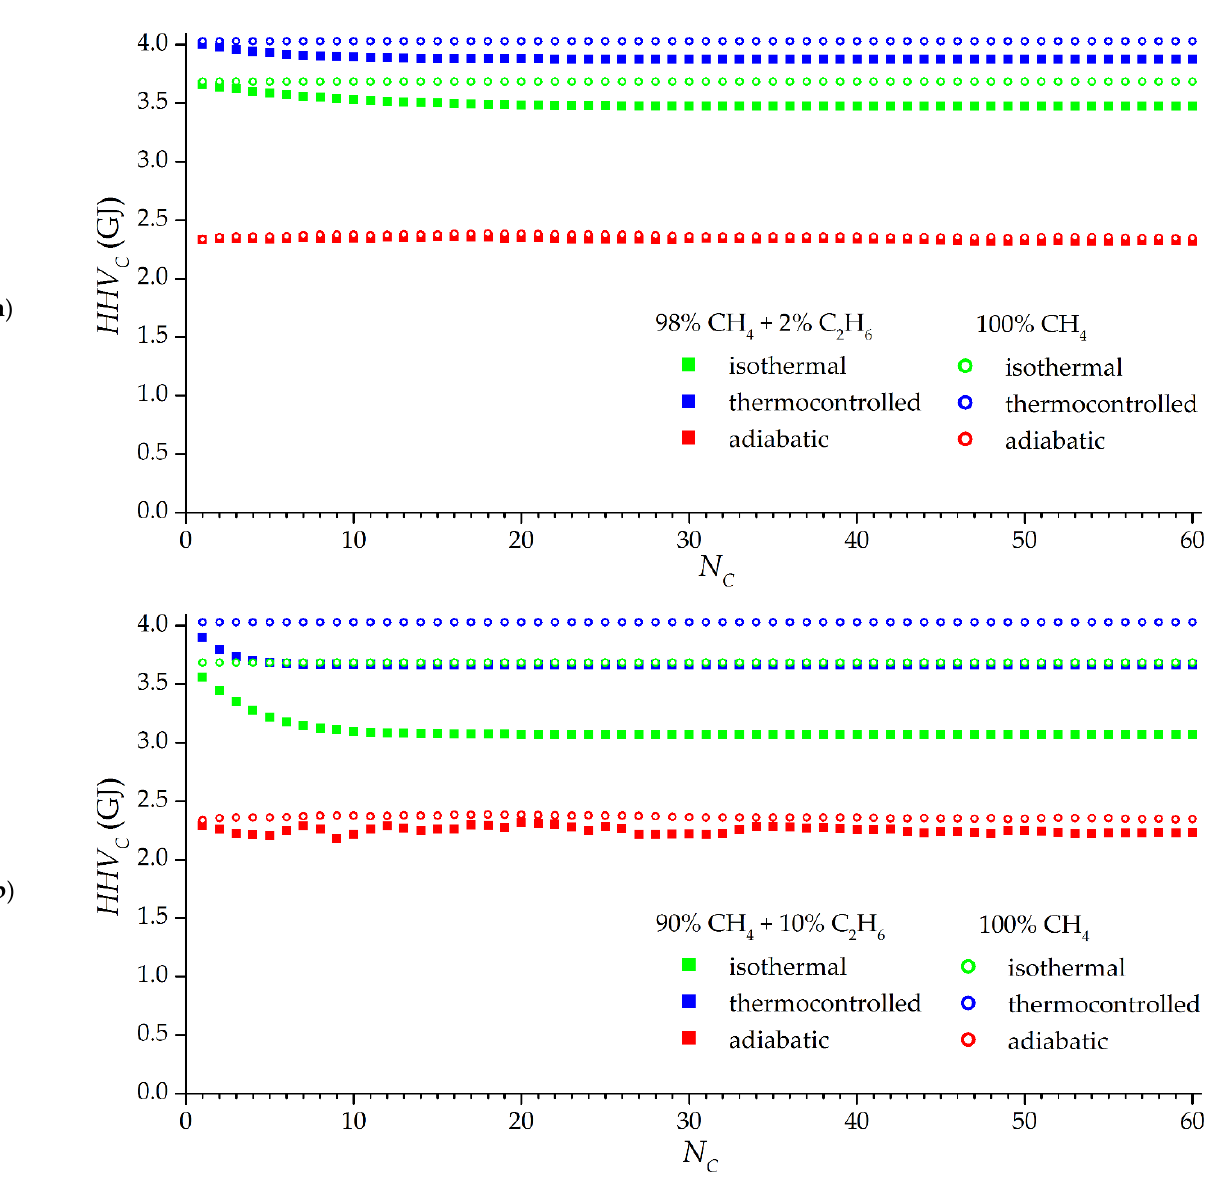
Figure 15. Dependence of the higher heating value of the mixed gas leaving for one cycle from a storage with a volume of 1 m 3 based on the ACPK adsorbent, on the cycle number. Filled dots correspond to mixtures: 98% mol. methane and 2% mol. ethane ( a ); 90% mol. methane and 10% mol. ethane ( b ). Empty points correspond to pure methane.